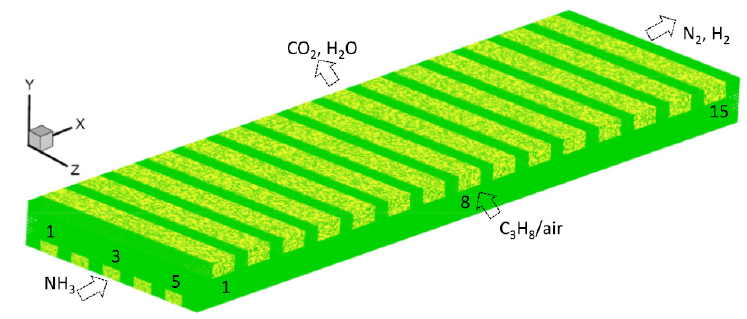
Figure 11. 3D schematic of a cross-flow microreactor [35].